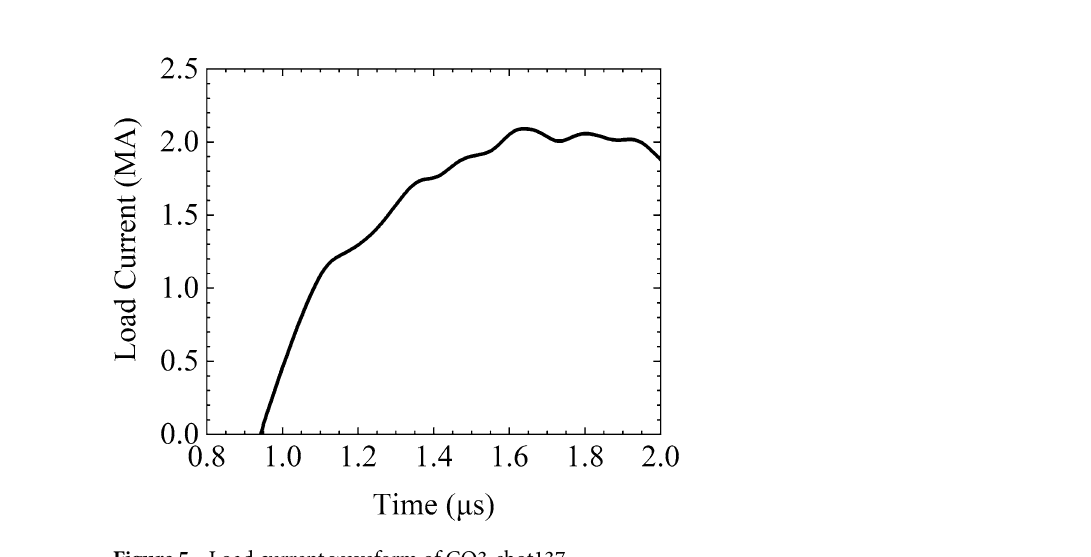
Figure 5. Load current waveform of